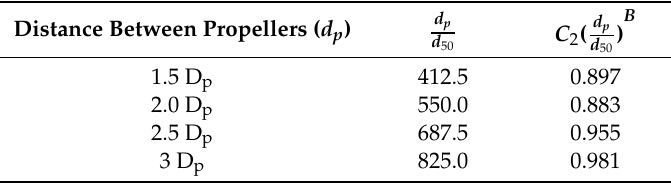
(cid:18) (cid:19) B d p d 50